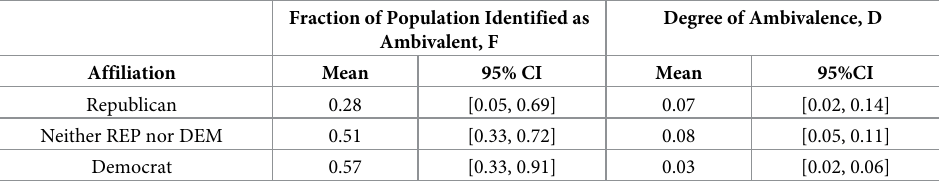
Table 2. Study-1 ambivalence parameters. The degree of ambivalence D only refers to that fraction of the population that showed any level of